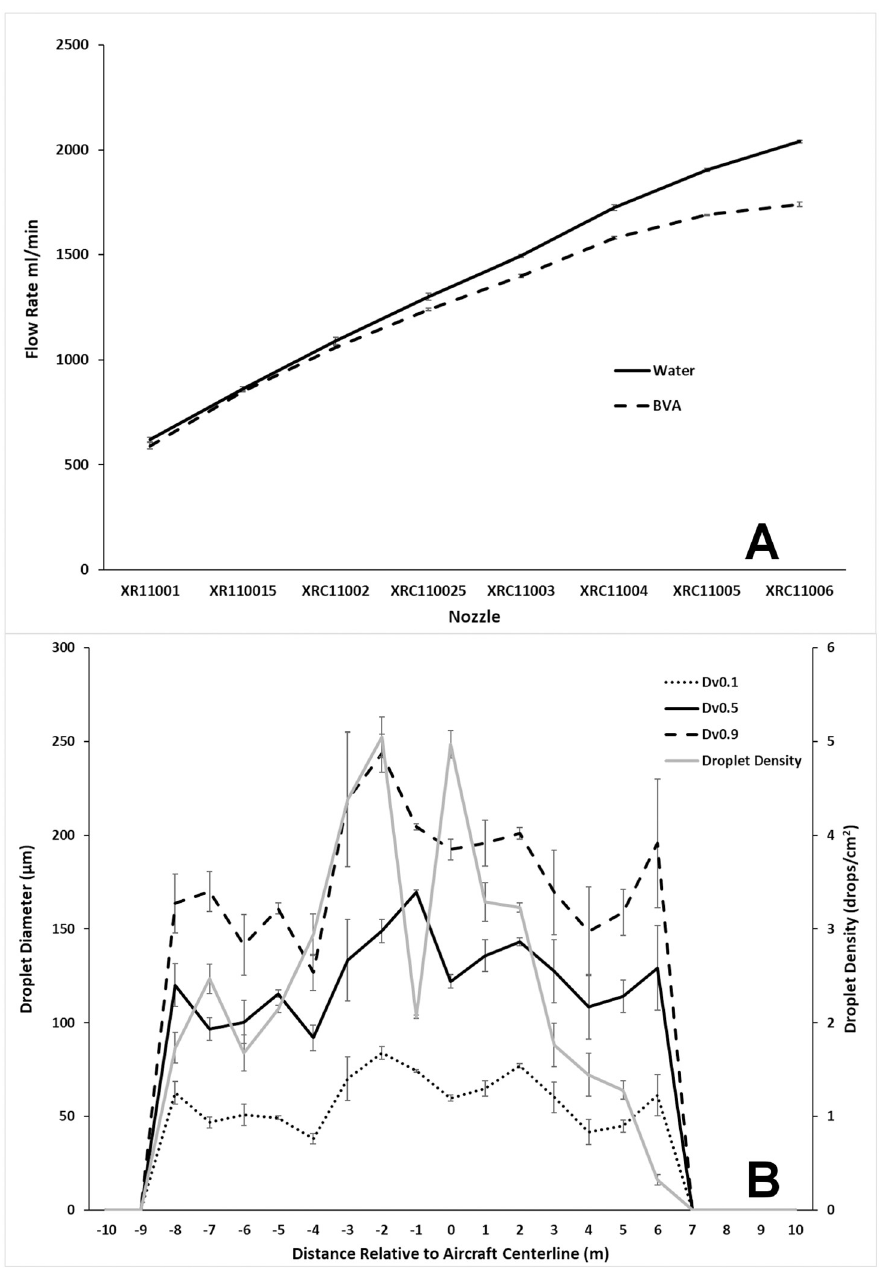
Fig 2. A. Average flow rate for two XR TeeJet nozzles applying water or BVA 13 oil at a pressure of 2 bar ± SEM. B. Swath width and droplet diameter (left axis) and droplet density (right axis) of BVA 13 oil ( ± SEM) applied at a rate of 591 mL/min from DJI s1000+ UAS flying 4.4 m/sec at an altitude of 10